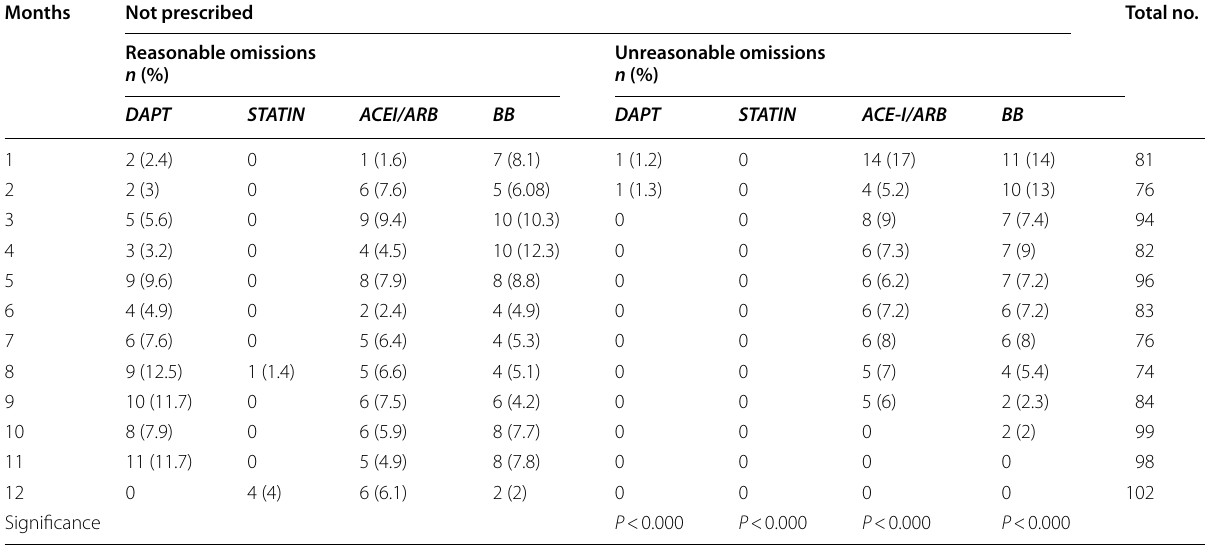
ACEI angiotensin-converting enzyme inhibitor, ARB angiotensin receptor blocker, DAPT dual antiplatelet therapy, BB beta-blocker, n number of patients